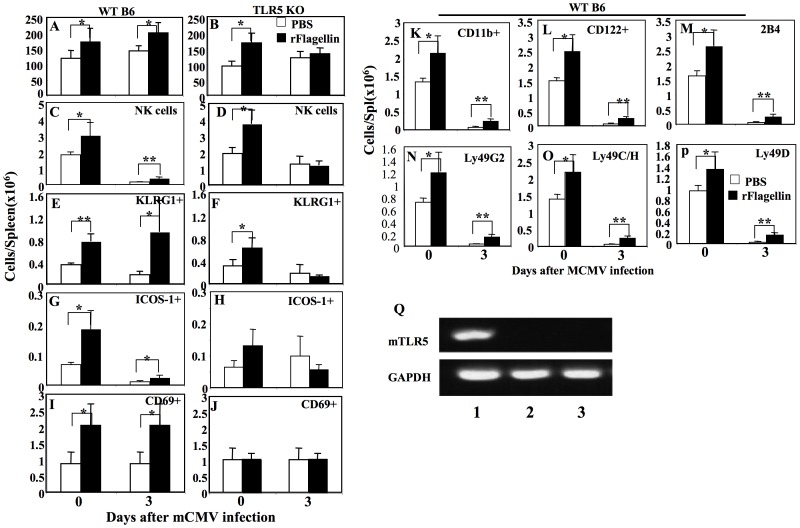
rFlagellin treatment increased NK cell activation in the absence and presence of mCMV infection.Splenocytes were harvested from rflagellin- and PBS-treated WT B6 and TLR5 KO B6 mice on day 0 and 3 after mCMV infection (1×105 pfu/mouse i.p). A and B. Nucleated cells per spleen were determined from WT B6 and TLR5 KO B6 mice. C–J. Numbers of: CD3-NK1.1+ NK cells (C and D); KLRG2+ NK cells (E and F); ICOS-1+ NK cells (G and H); and CD69+ NK cells (I and J) per spleen were measured from WT B6 and TLR5 KO B6 mice. K–P. Numbers of: CD11b+ NK cells (K); CD122+ NK cells (L); 2B4+ NK cells (M); Ly49G2+ NK cells (N); Ly49C/H+ NK cells (O); and Ly49D+ NK cells (P) per spleen were determined from rflagellin- and PBS-treated WT B6 mice on day 0 and 3 after mCMV infection. The “*” and “**” represent p values<0.05 and <0.005, respectively, Students t-test. Q. mRNAs were harvested from the TLR5-transfected and TLR5-ve Null cells and FACS-sorted splenic CD3-NK1.1+ NK cells from naïve WT B6 mice as described in Materials and Methods. The cDNA bands specific for TLR5 and GAPDH were measured by RT-PCR and were visualized by ethidium bromide staining. Lane 1 = TLR5 expressing cells, Lane 2 = FACS sorted NK cells, and Lane 3 = TLR5-ve Null cells.